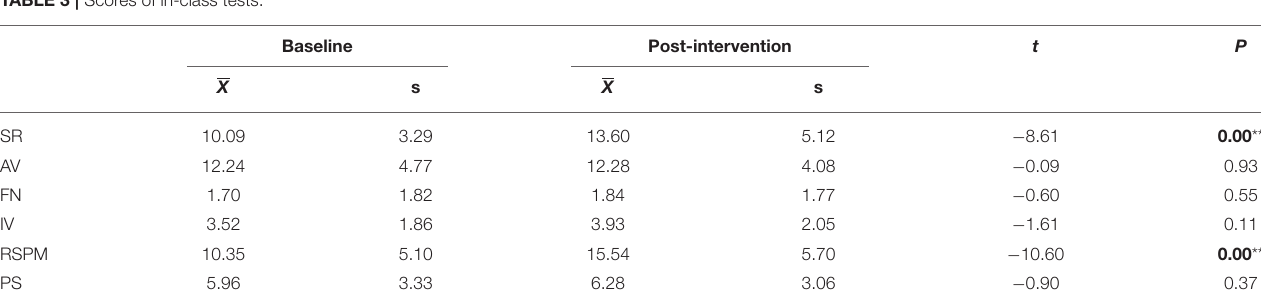
TABLE 3 | Scores of in-class tests.